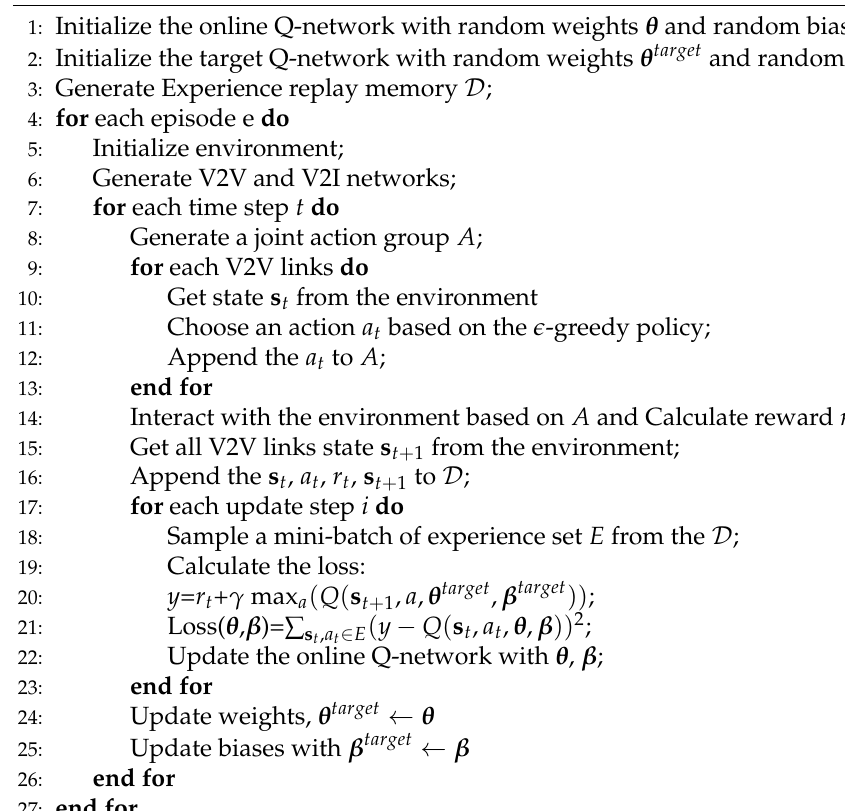
Algorithm 1 Training algorithm